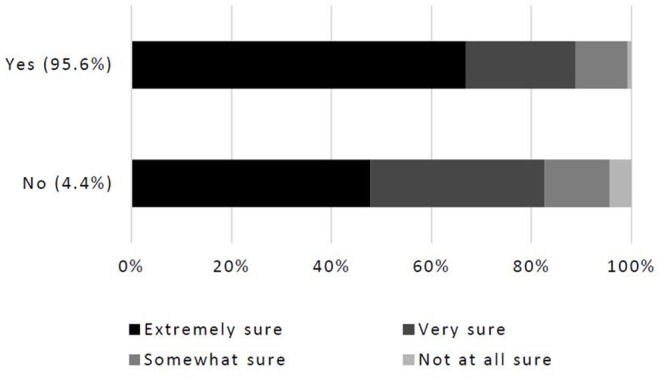
Percentage of veterinarian participants who believe, or do not believe, that climate change is occurring and their level of confidence in that belief (n = 521).